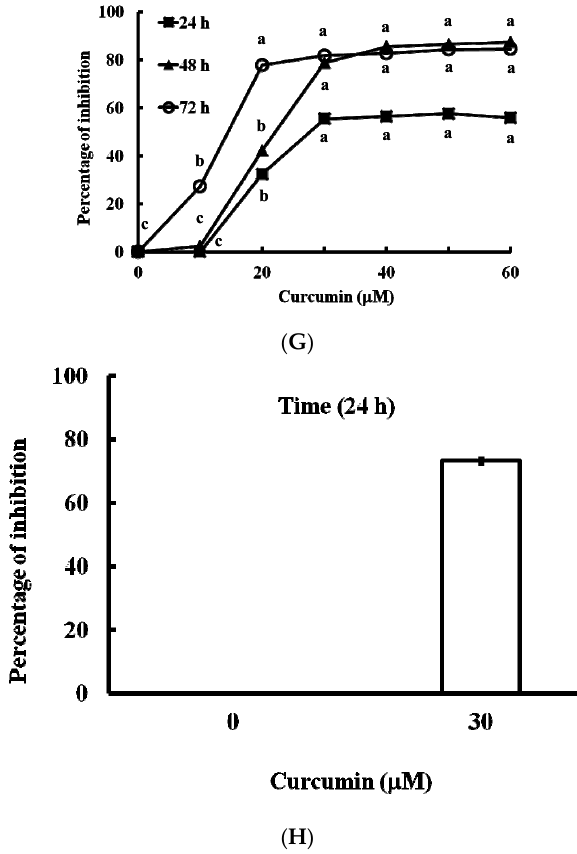
Figure 2. Confirmation of the effects of curcumin on HT29 cells. ( A ) Curcumin reduced nuclear NF- κ B expression. Nuclear proteins were prepared for Western blot analysis by using anti-p65 NF- κ B antibody. Rack 1 served as a loading control. ( B ) Curcumin suppressed I κ B- α phosphorylation. ( C ) Curcumin reduced Aurora-A protein expression. ( D ) Curcumin inhibited Aurora-A kinase activity. After treatment, total cell lysates underwent Western blot analysis with anti-phospho-I κ B α , anti-Aurora-A, and anti-phospho-Aurora-A antibodies. β -actin served as a